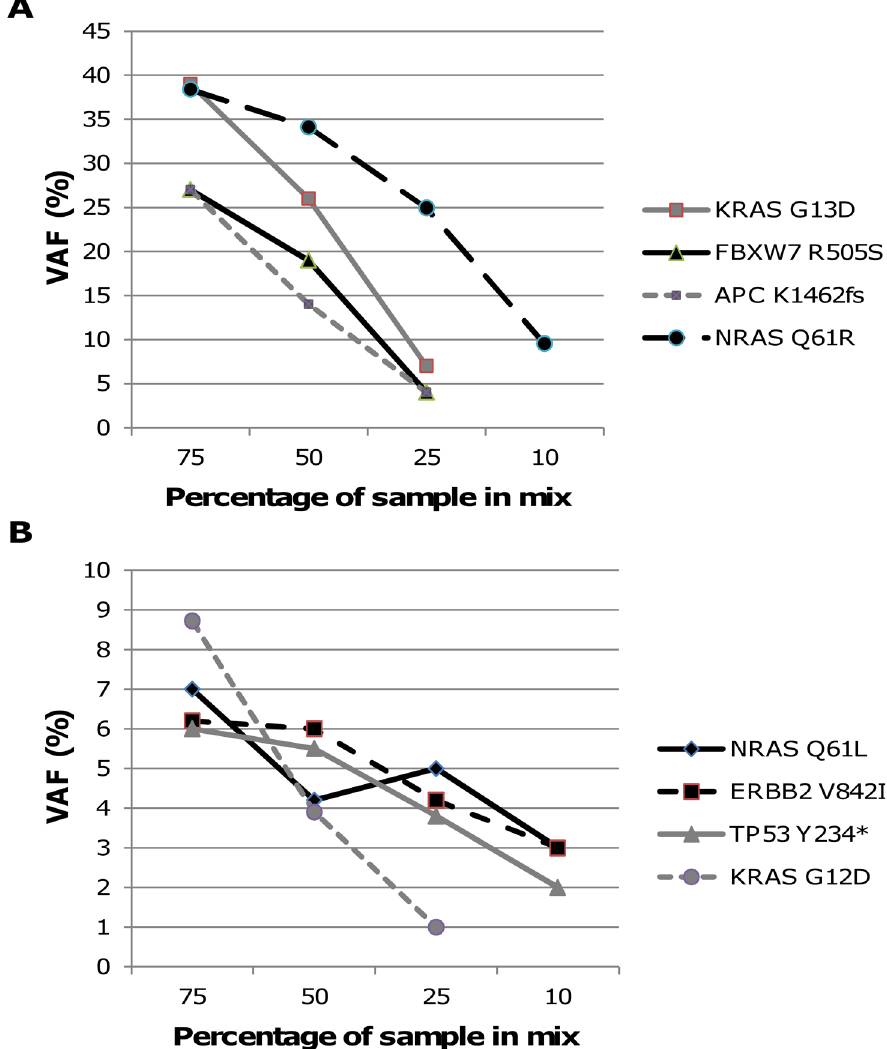
Fig 3. Limit-of-detection assay. Two samples with known mutations were mixed at different percentages, captured and sequenced. VAFs of each mutation were plotted against the percentage in the mix. (A) Mutations KRAS G13D (58%), FBXW7 R505S 48%), APC K1462fs (52%), NRAS Q61R (35%) with high VAFs in the original sample. (B) Mutations NRAS Q61L (9%), ERBB2 V842I (8%), TP53 Y234 * (9%), KRAS D12D (24%) with low VAFs in the original